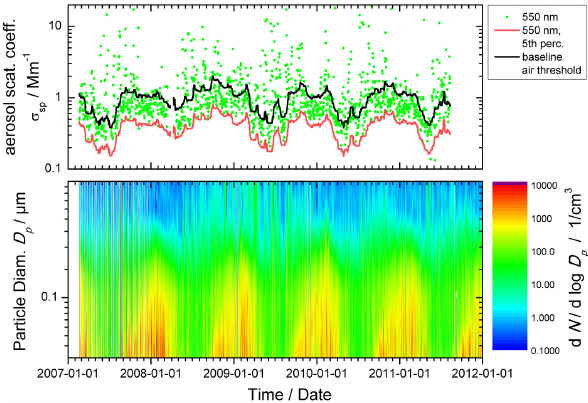
Fig. 1. Troll 2007–2011 time series of aerosol scattering coefficient (550nm, daily averages, upper panel) and particle number size dis- tribution (PNSD, lower panel). The upper panel also contains the time series of the 550nm aerosol scattering coefficient running 4- week 5th percentile (light red, based on hourly values) to underline the annual cycle of the baseline aerosol properties. Furthermore, the baseline air mass threshold criterion based on the 550nm aerosol scattering coefficient running 4-week 5th percentile is also plotted (black line). The PNSD, measured by differential mobility parti- cle sizer (DMPS), is shown as a colour contour surface plot with time on the x axis, particle diameter on the logarithmic y axis, and logarithmic colour code for the particle number concentration (nor- malised by logarithmic size interval). Both data sets are cleared for instrument malfunctions, but not for local